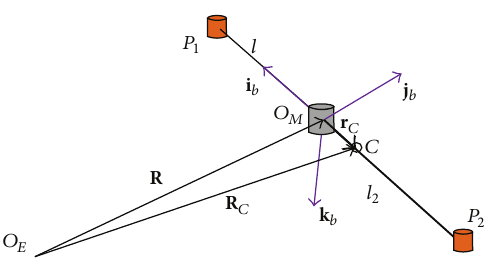
Figure 5: The schematic of MMET with structure bias.